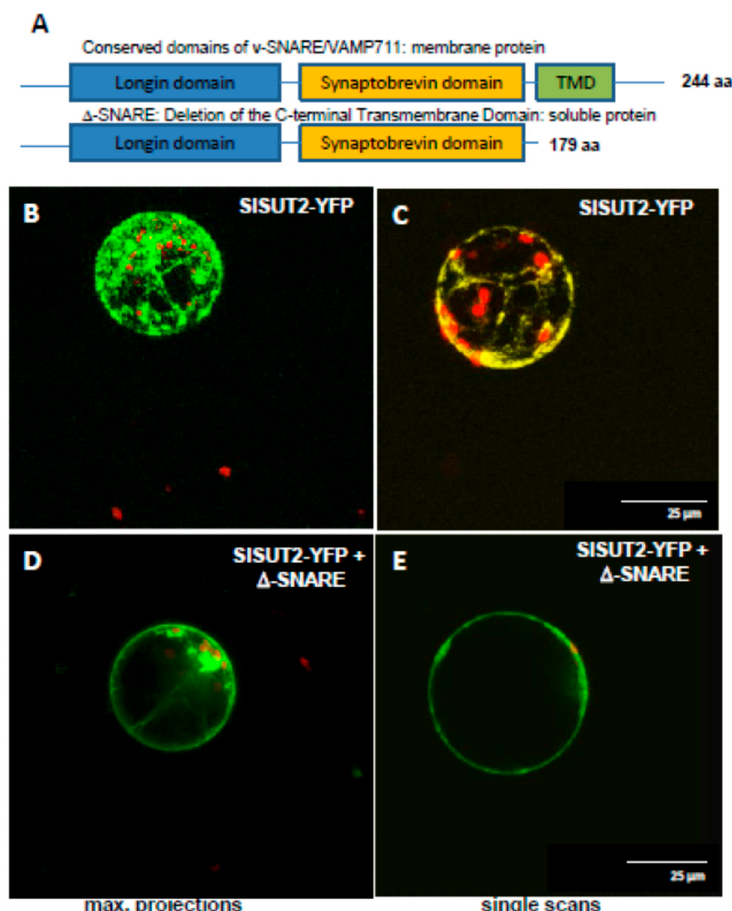
Figure 5. SlSUT2 co-expressed with the interacting VAMP711 protein. A. Schematic representation of conserved domains within the v-SNARE/VAMP711 protein being one of the SlSUT2 interaction partners [2] . Upper panel: full length version of the protein; lower panel: D-SNARE protein with truncation of the C-terminal transmembrane spanning domain. B and C. Protoplasts of Nicotiana tabacum transformed with a SlSUT2-YFP fusion construct. D and E. Protoplasts co-expressing SlSUT2-YFP together with the truncated version of the v_SNARE/VAMP711 protein D-SNARE. Only the SlSUT2 protein is visible in green, whereas the D-SNARE protein is not tagged. B and D. Maximum projections of z-stacks, C and E. Single scans. Chlorophyll is shown in red, YFP is shown in green (B, D, E) or yellow (C).